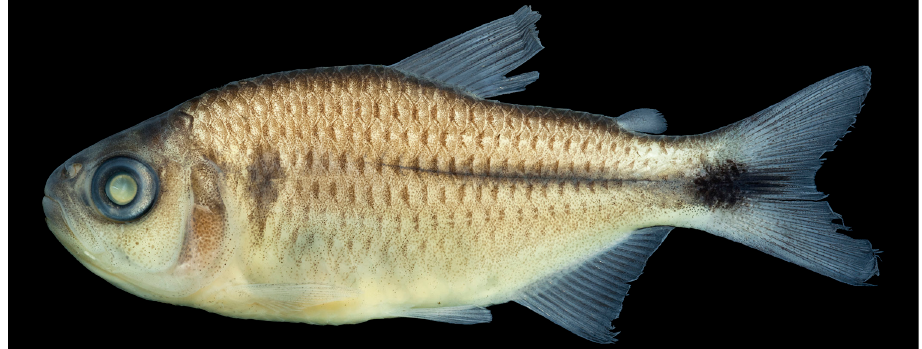
FIGURE 1 | Holotype of Moenkhausia cambacica , MZUSP 125792, 34.8 mm SL, Brazil, Rondônia State, Municipality of Vilhena, rio Madeira basin, upper rio Machado drainage.